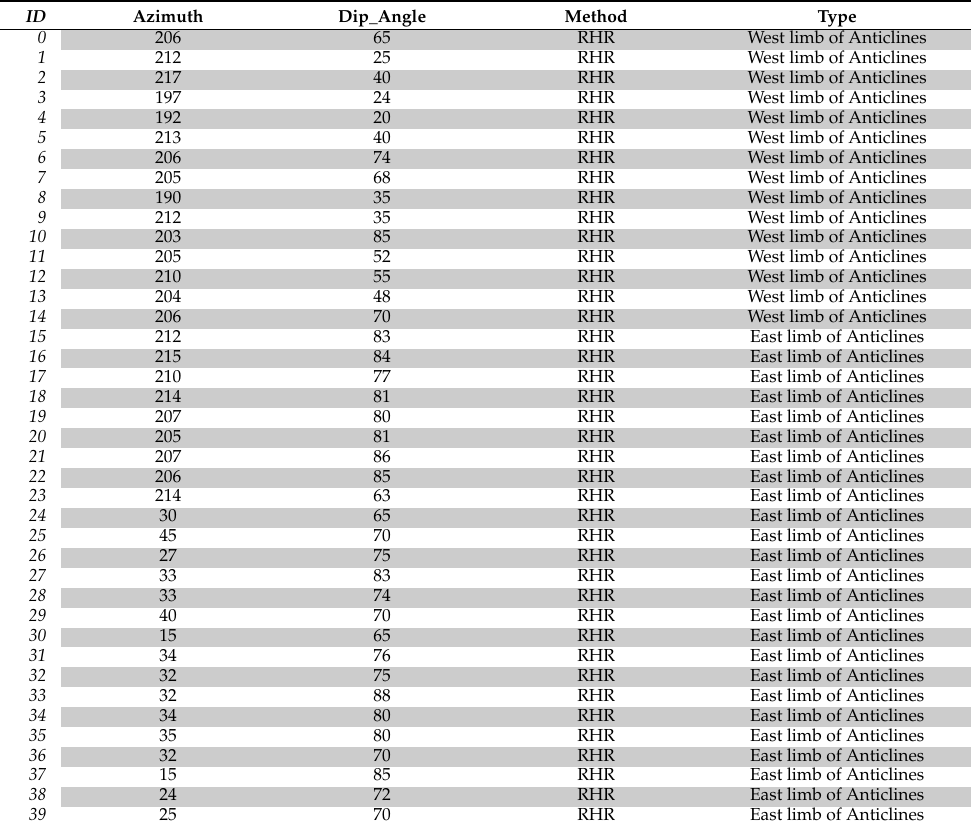
Table A2. Macduff dataset with data differentiation evidenced by the field investigator (i.e., data is split into ‘West limb of Anticlines’ and ‘East limb of